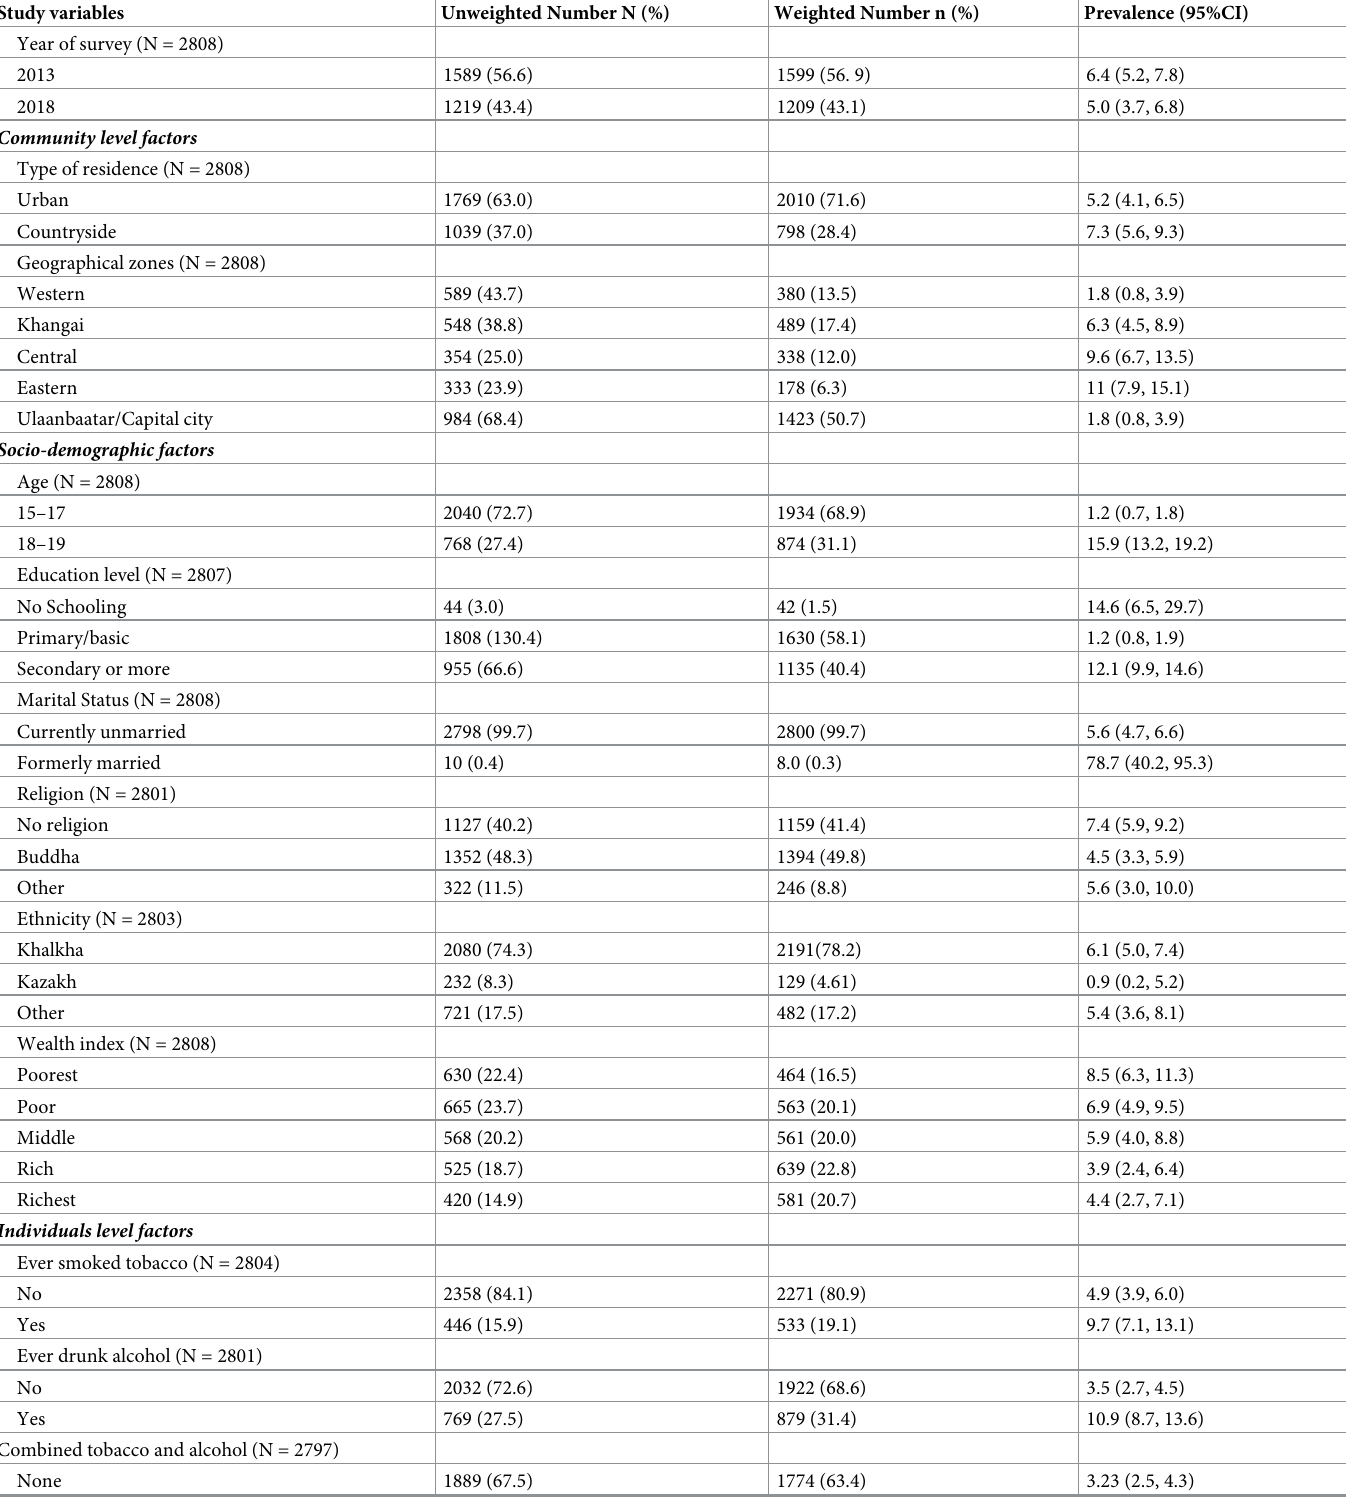
Table 1. Characteristics of the sample, prevalence and 95% confidence intervals. Mongolia SISS 2013 and 2018 (N * =